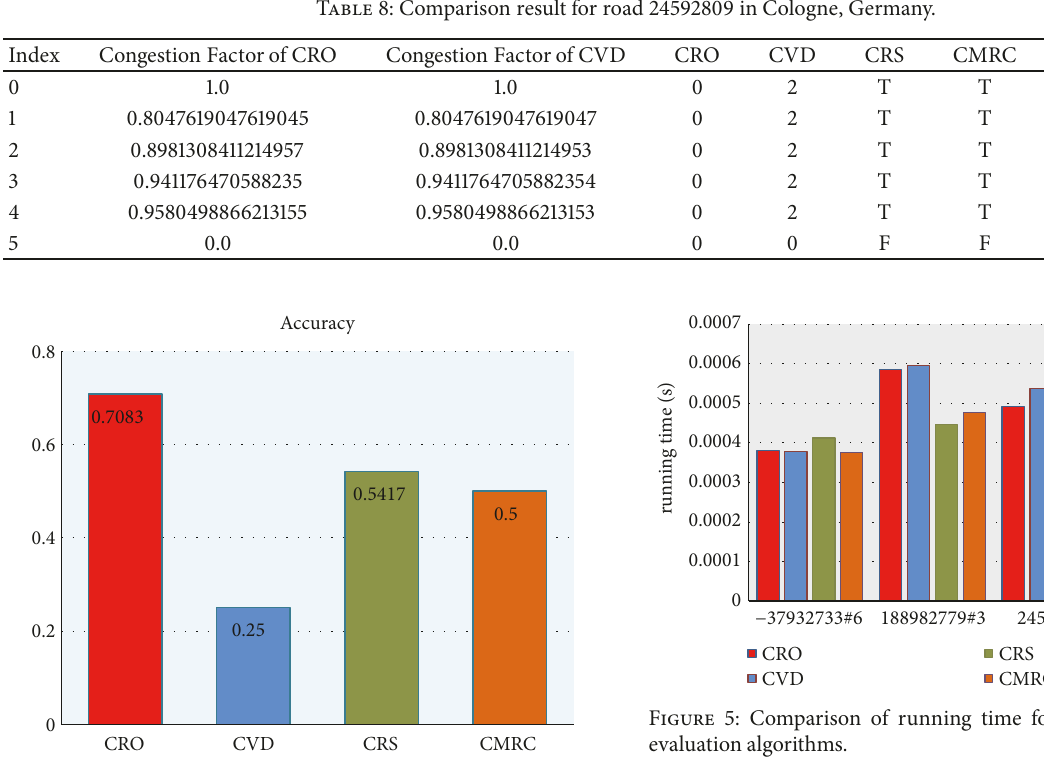
Table 8: Comparison result for road 24592809 in Cologne, Germany.